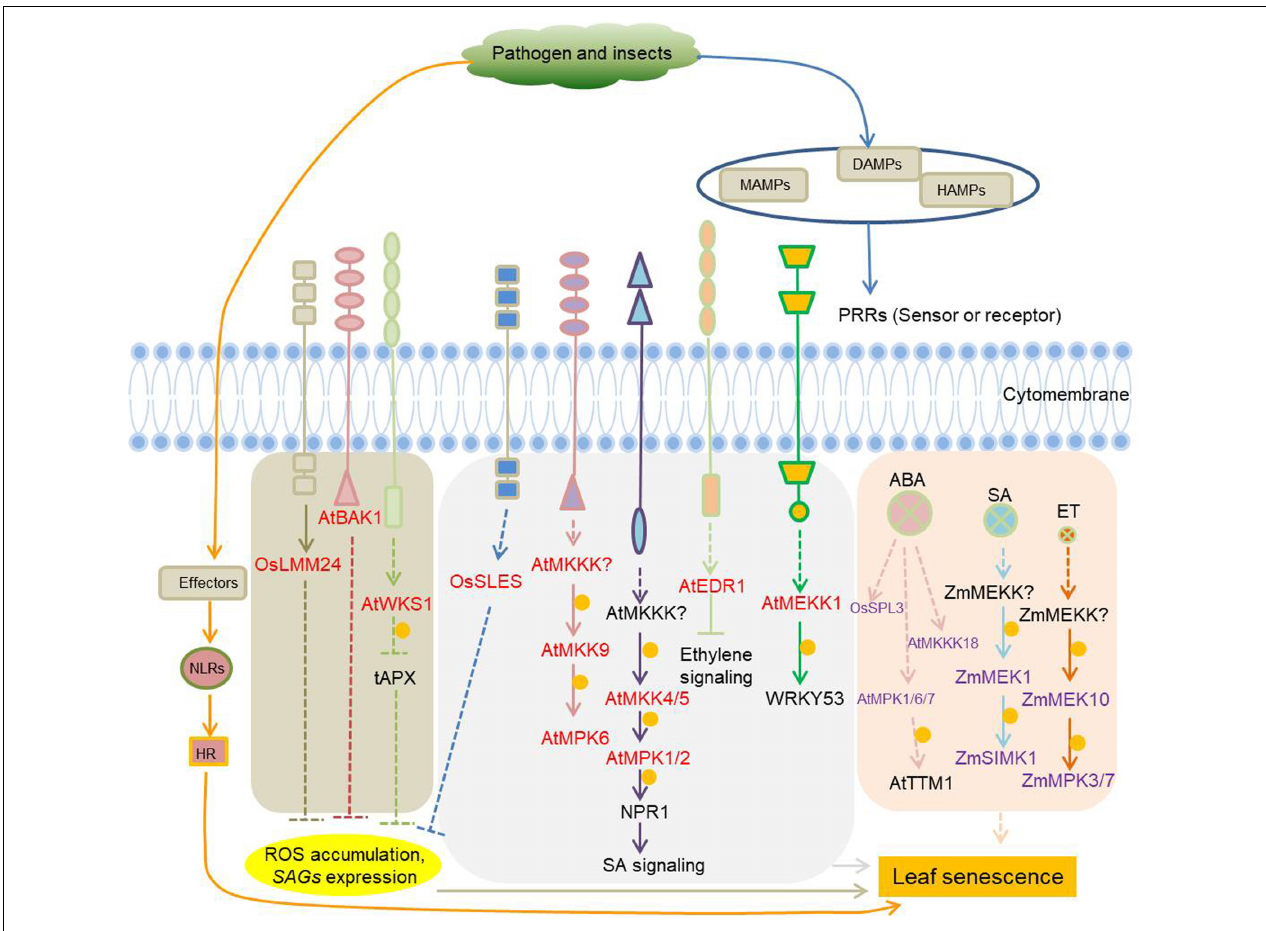
FIGURE 4 | Protein kinases involved in the regulation of plant immunity-related leaf senescence. Pathogens and pests induce microbial-associated molecular patterns (MAMPs) and damage-associated molecular patterns (DAMPs) or herbivore-associated molecular patterns (HAMPs) that can be recognized by specific plant receptors (pattern recognition receptors, PRRs) to initiate cell-surface immunity. PRRs are receptor-like kinases (RLKs) or receptor-like proteins (RLPs) in plants. RLKs are composed of an extracellular ligand binding domain, a transmembrane region, and an intracellular kinase domain. RLPs have a similar structural organization to RLKs, but lack the kinase domain. Pathogens/pests can also deliver elicitors/effectors to inside of cells, and these elicitors/effectors can be sensed by intracellular immune receptors (NLRs) to initiate intracellular immunity, which will lead to hypersensitive response (HR), a form of programmed cell death (PCD). Cell-surface immunity and intracellular immunity activate downstream short-term and long-term defense responses, respectively. The kinases involved in plant immunity-mediated leaf senescence are marked in red. The kinases marked in purple are leaf senescence regulars, whether they function in response to immunity is unknown. Arrows show that the process is promoted, and the T-bars mean the process is inhibited. Yellow circles indicate phosphorylation. OsLMM24, O. sativa lesion mimic mutant 24; BAK1, BRI1-associated receptor kinase; WKS1, wheat kinase-start 1; tAPX, thylakoid-associated ascorbate peroxidase; OsSLES, O. sativa spotted leaf sheath; MKKKs or MEKKs, MAPK kinase kinases; MKKs or MEKs, MAPK kinases; NPR1, non-expresser of PR genes 1; EDR1, enhanced disease resistance 1; OsSPL3, O. sativa spotted leaf